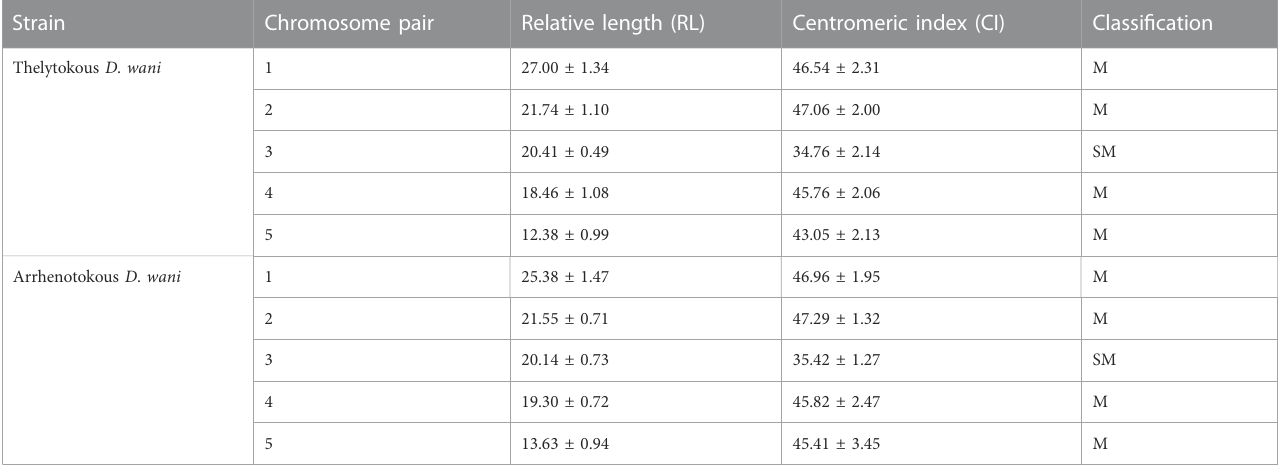
TABLE 2 Karyotypic parameters of females of the two strains of D. wani : Mean ± Standard deviation. Chromosomes are classi fi ed into metacentric (M), submetacentric (SM), and acrocentric (A) according to the CI value of Levan et al. (1964).